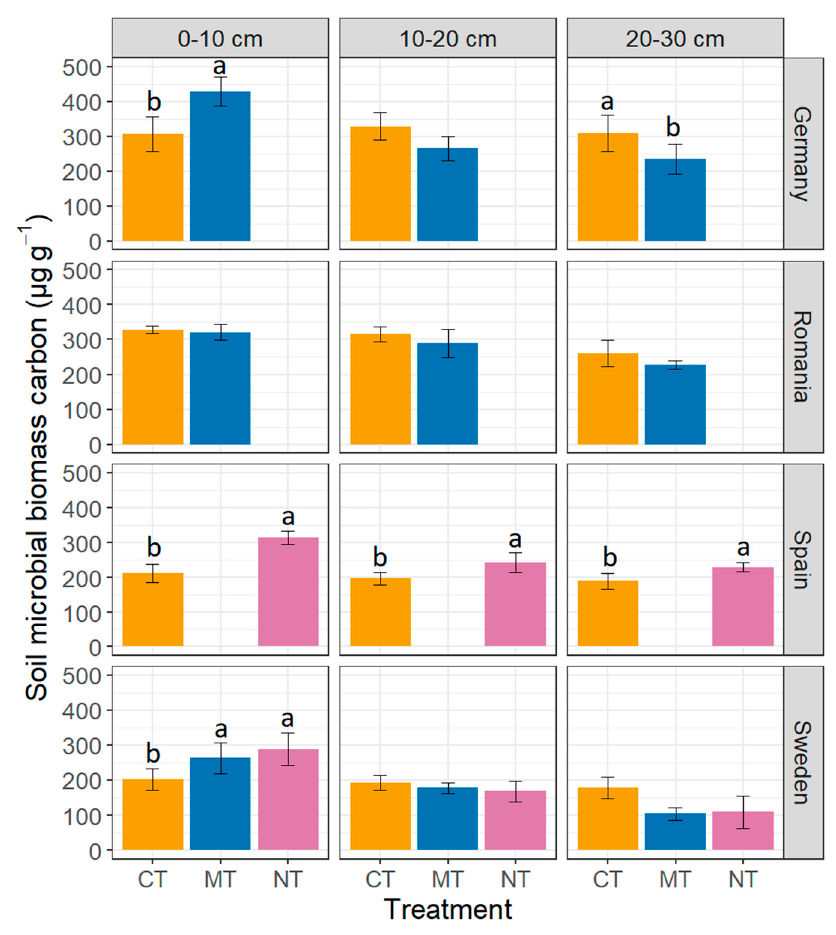
Figure 1. Effect of tillage treatments (CT = Conventional tillage, MT = Minimum tillage, NT = No-